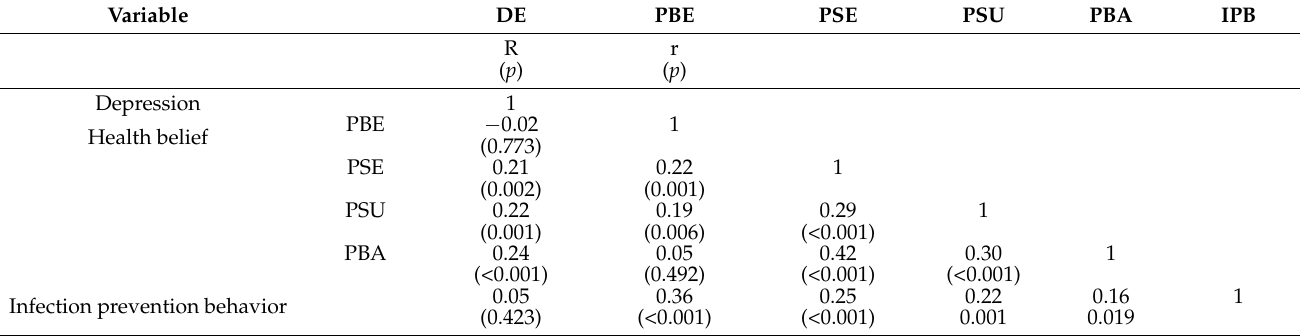
Table 2. Correlation between observed